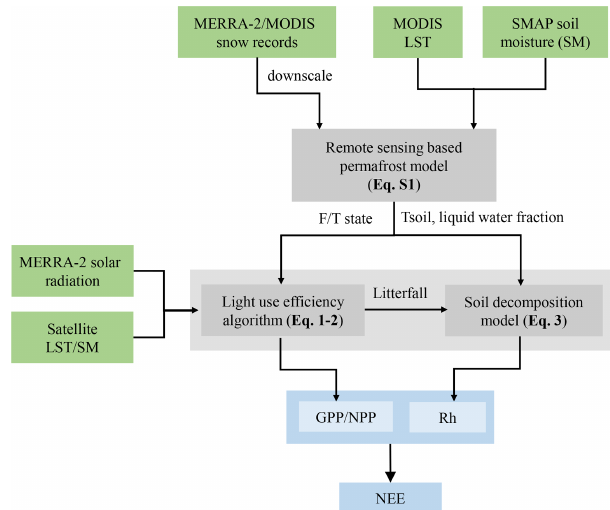
Figure 1. Flow diagram describing the modeling procedure and main input data sets used in this study. The terrestrial carbon flux model has two components, including the light use efficiency al- gorithm for vegetation productivity estimates and a soil decompo- sition model for soil heterotrophic respiration estimates. The main equations used for each modeling component are referenced in the appropriate modeling